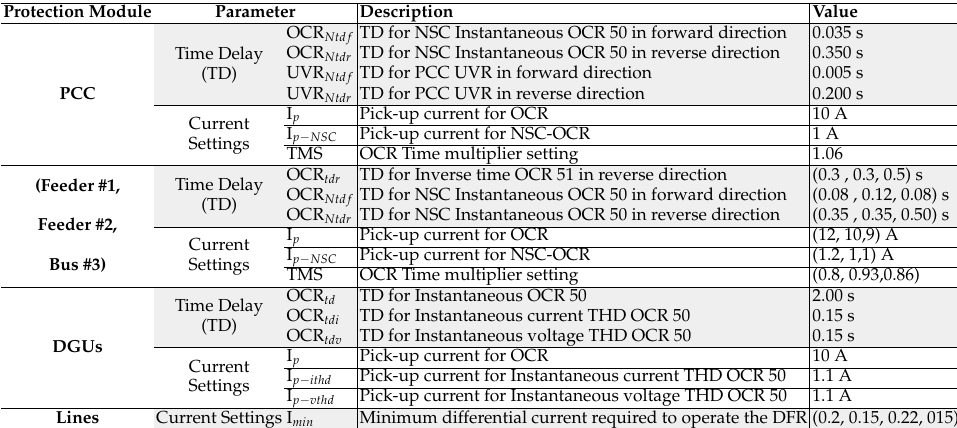
Table 2. Time delays and protective parameter